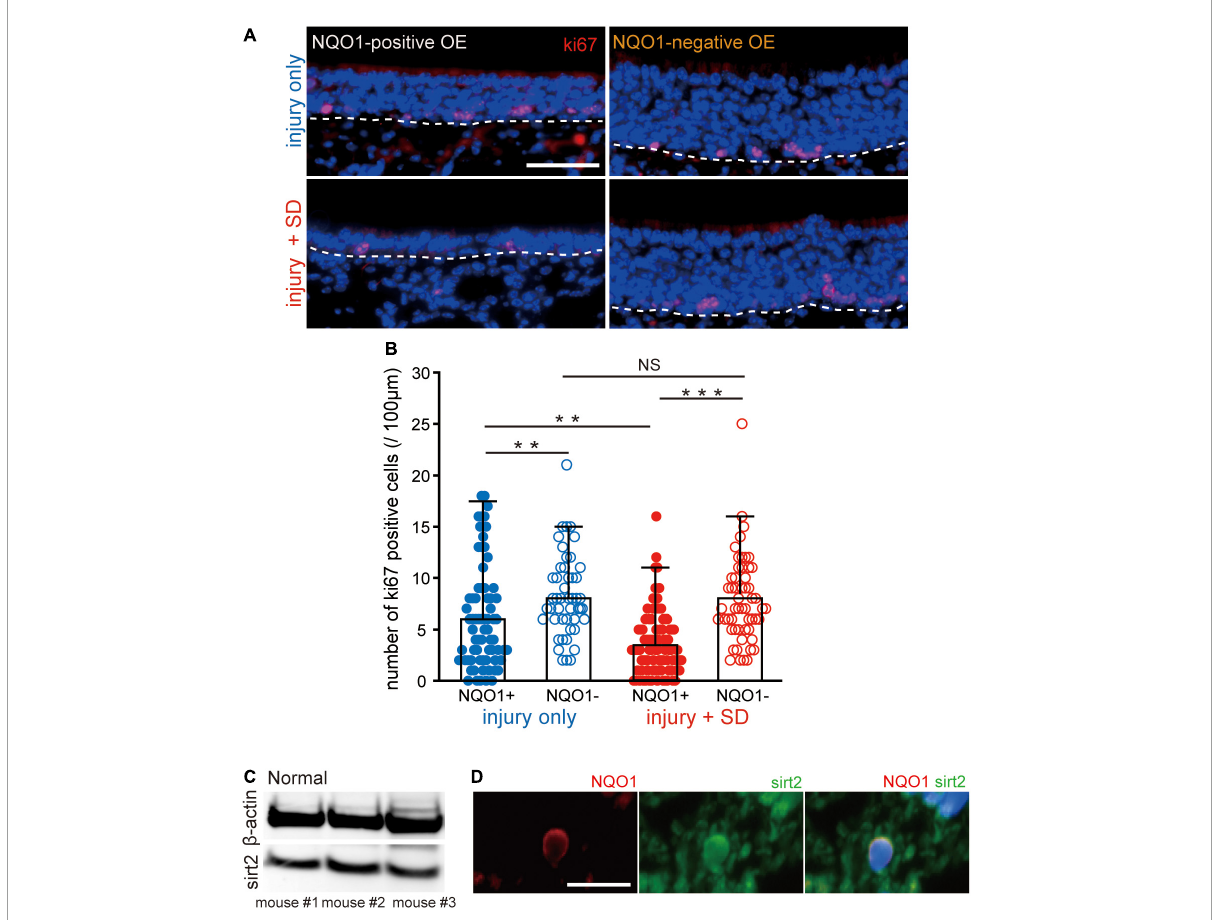
FIGURE5 Sleep deprivation induces downregulation of proliferation in the NADPH quinone oxido-reductase 1 (NQO1)-positive olfactory epithelium (OE) following injury. (A) Coronal sections stained with anti-ki67 antibody in the NQO1-positive (left) and –negative OEs (right), in mice with injury only (upper, injury only) and mice with injury combined with sleep deprivation (SD) (lower, injury + SD). The dashed line represents the basement membrane of the OE. Scale, 50 µ m. (B) Counts of ki67-positive cells in the NQO1-positive and –negative OE, in injury only and injury + SD mice. Injury only mice exhibited fewer ki67-positive cells in the NQO1-positive OE than in the NQO1-negative OE. In mice with injury combined with SD, the number of ki67-positive cells was significantly lower in the NQO1-positive OE compared with the NQO1-negative OE. The extent of the reduction in the NQO1-positive OE in injury + SD mice was greater than that in injury only mice. *** p < 0.001, ** p < 0.05, NS, not significant, Steel–Dwass test. (C) Detection of sirt2 protein in the OE. Total protein from 30 µ g weight olfactory mucosa was separated and analyzed for sirt2 and β -actin by western blotting. The anti- β -actin antibody was used as an internal reference. (D) Coronal sections stained with anti-NQO1 (red) antibody and anti-sirt2 (green) antibody in mice with injury combined with SD. NQO1-positive cell was co-stained with an anti-sirt2 antibody. Scale, 20 µ